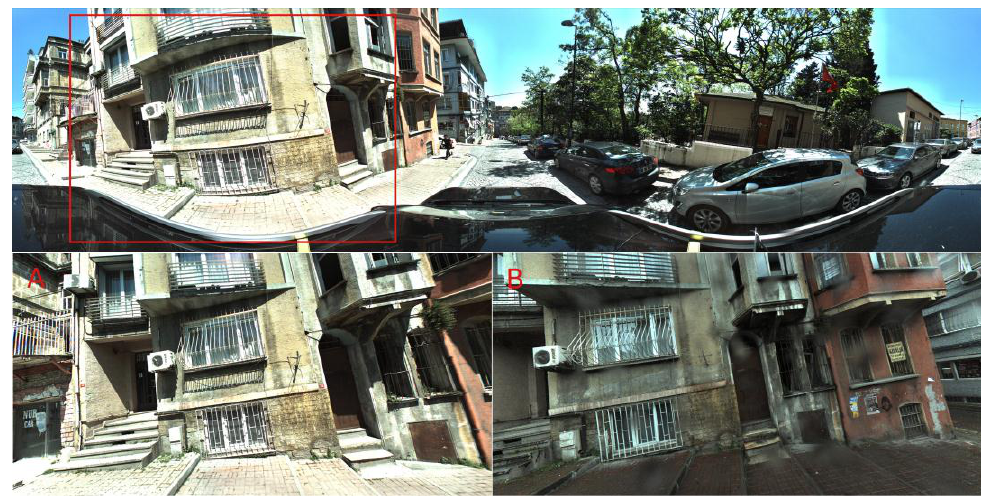
Figure 13. Upper section: example of omnidirectional image. Lower section: ( A ) Partial rectilinear re-projection of the omnidirectional image. Only a portion of the original image is visible, but the operator can dynamically change the angle of view, direction, and apparent zoom in the re-projected image. ( B ) Rectilinear projection of an omnidirectional image taken in the sample place at a different time, and with rainy weather.